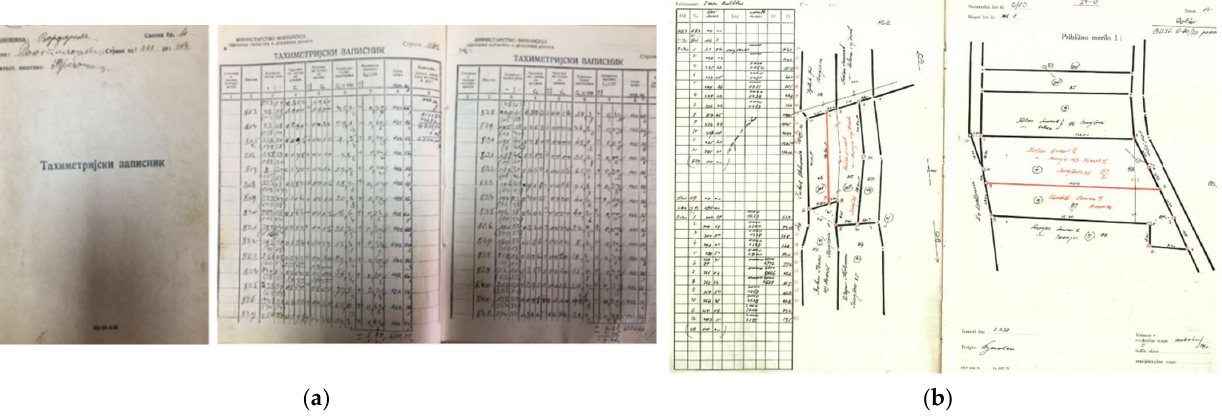
Figure 3. ( a, b ) Surveying field books; ( a ) Surveying field book from initial cadastral survey—North Macedonia; ( b ) Surveying field books in process of cadastral